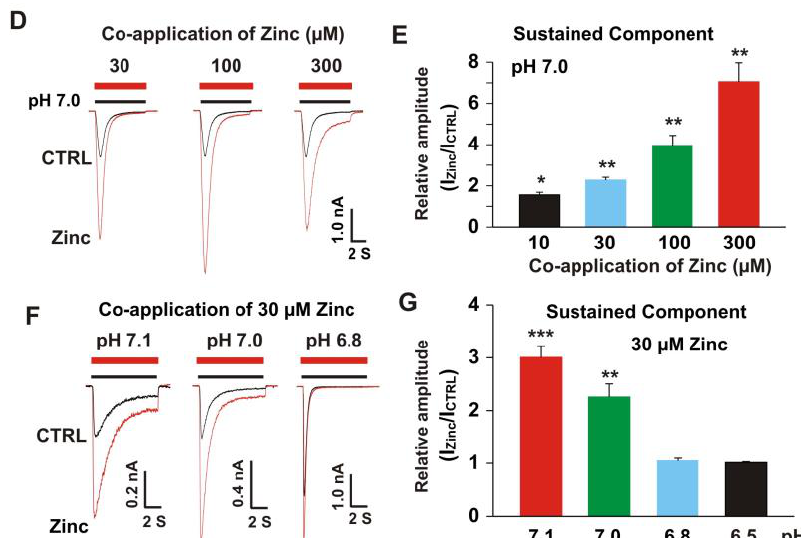
Figure 3. Co-application of zinc potentiated the peak and sustained component of heteromeric ASIC1a / 3 currents with pH dependence. ( A ) Representative traces show that zinc dose-dependently enhanced the currents of heteromeric ASIC1a / 3 channels recorded on a CHO cell expressing both ASIC1a and ASIC3 subunits; ( B ) Dose-dependent curve of co-application of zinc on heteromeric ASIC1a / 3 channels. The curve revealed a bell shape. The EC 50 for zinc concentration between 1 and 100 µ M was 26.0 ± 3.2 µ M ( n = 10) and the EC 50 for zinc concentration between 100 and 1000 µ M was 343.2 ± 49.0 µ M ( n = 10); ( C ) Statistical data show that co-application of zinc at a concentration of 300 µ M, but not 10, 30, and 100 µ M increase the sustained component of heteromeric ASIC1a / 3 currents by a drop in pH from 7.4 to 6.8 ( n = 12); ( D ) Representative traces show that co-application of zinc at concentrations of 30, 100, and 300 µ M potentiate both peak amplitude and sustain component of heteromeric ASIC1a / 3 currents by a drop in pH from 7.4 to 7.0; ( E ) Statistical data show that co-application of zinc dose-dependently increase sustained component of heteromeric ASIC1a / 3 currents by a drop in pH from 7.4 to 7.0 ( n = 8); ( F ) Representative traces show that co-application of